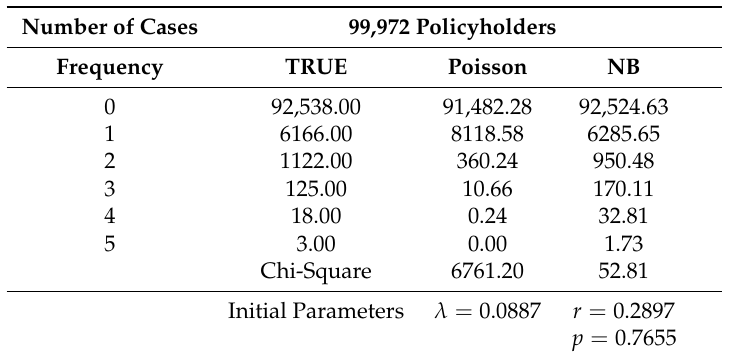
Table 1. Number of claims: true, Poisson and Negative Binomial (NB) fitted frequencies, and Chi-square statistic. At the bottom: Maximum Likelihood Estimation (MLE) parameters included.